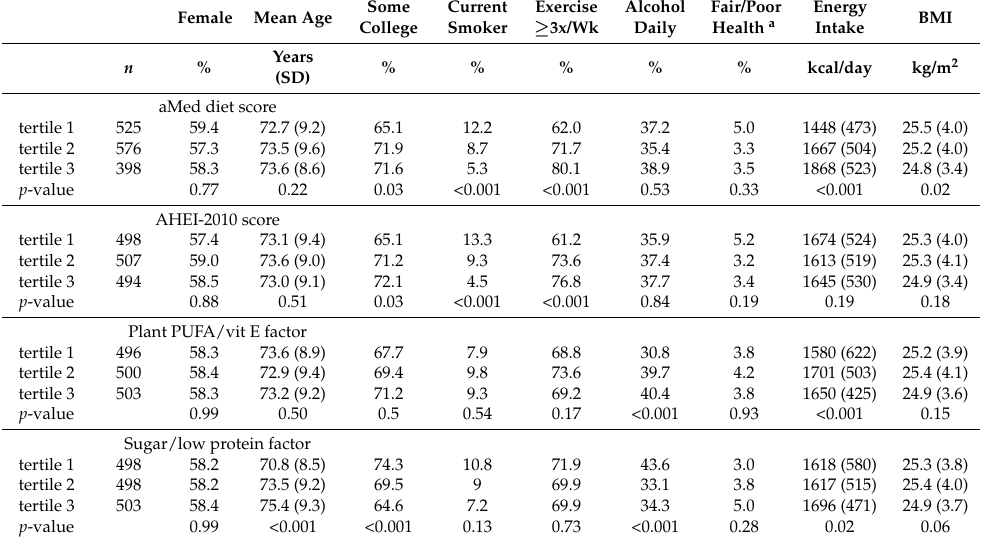
Table 2. Baseline (1988–1992) characteristics of participants according to sex-specific tertile of diet score/factor ( n =